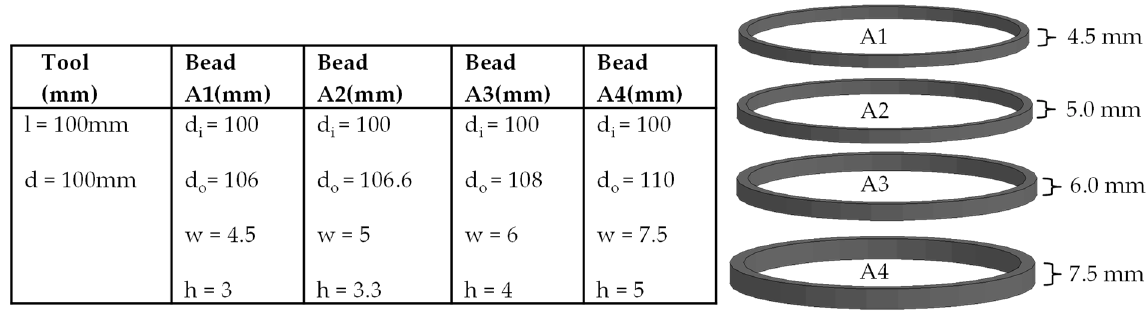
Figure 5. Dimensions of different beads for the reinforcement analysis.